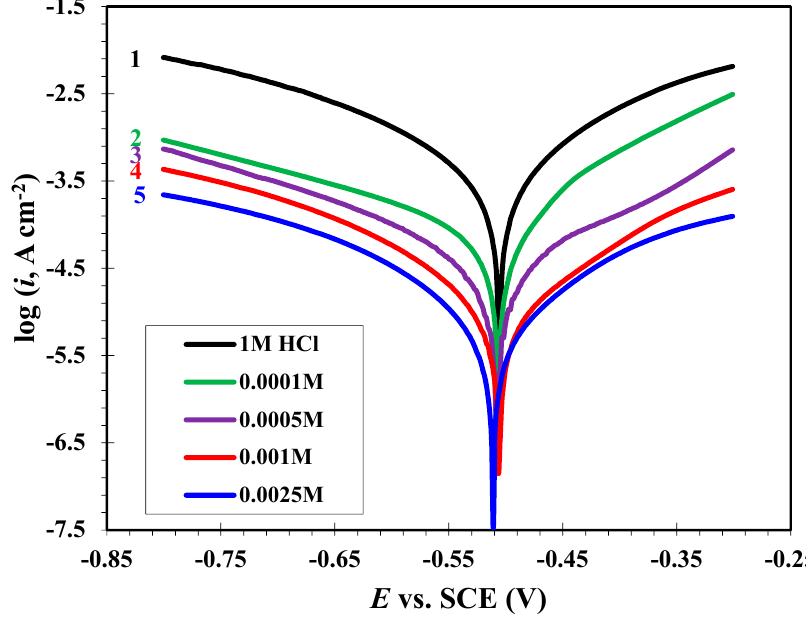
Figure 5. Anodic and cathodic polarization curves for MS obtained at 20 °C in 1 M HCl solution in the absence and presence of different concentrations of CGSES14.